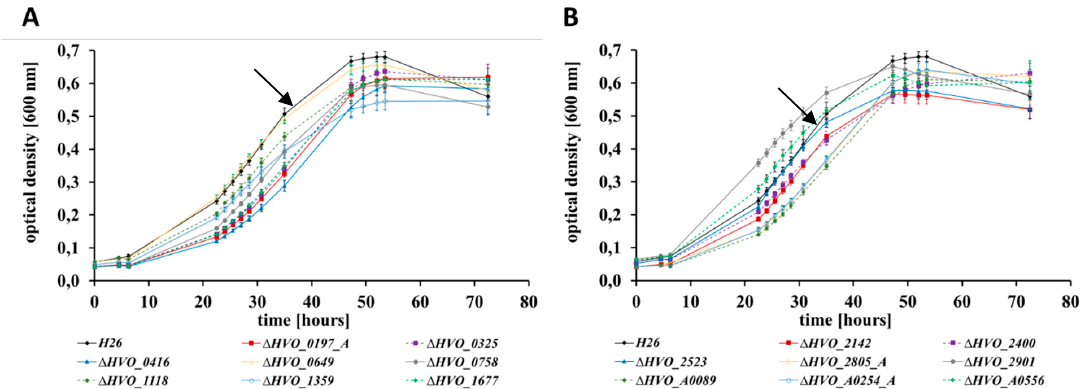
Figure 2. Growth curves of the parent strain H26 (black) and 16 deletion mutants (in color) grown in synthetic medium with glucose as carbon source. ( A ) Parent strain H26 (black) and deletion mutants ∆ 0197_A (red), ∆ 0325 (purple), ∆ 0416 (dark blue), ∆ 0649 (yellow), ∆ 0758 (grey), ∆ 1118 (dark green), ∆ 1359 (light blue), ∆ 1677 (light green). ( B ) Parent strain H26 and deletion mutants ∆ 2142 (red), ∆ 2400 (purple), ∆ 2523 (dark blue), ∆ 2805_A (yellow), ∆ 2901 (grey), ∆ A0089 (dark green), ∆ A0254_A (light blue), ∆ A0556 (light green). The wild-type is indicated by black arrows.